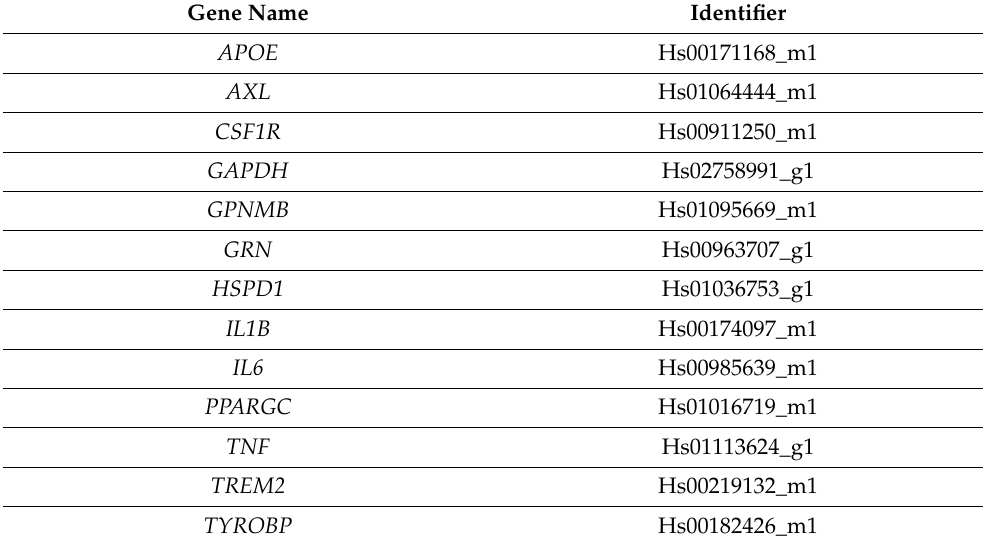
Table 1. Probes used for